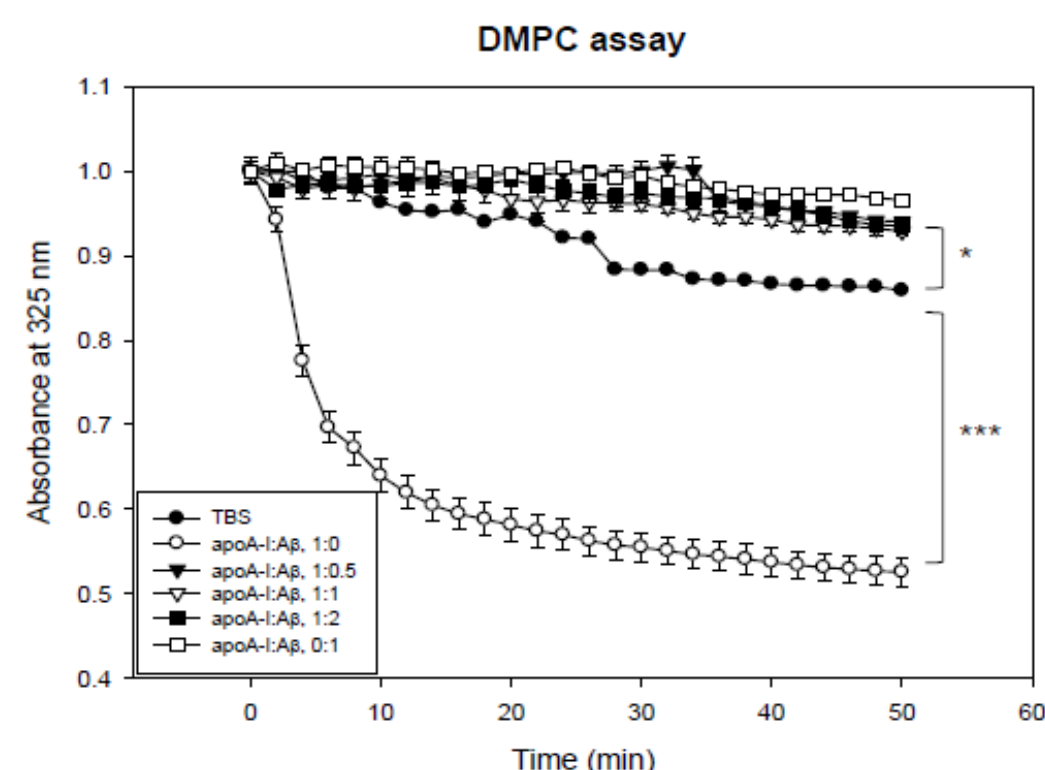
Figure 3. Kinetics of apoA-I and beta-amyloid (A β ) with DMPC multilamellar liposomes. The absorbance at 325 nm was monitored at 24.5 ◦ C at 2 min intervals. *, p < 0.05 between TBS (closed circle) and apoA-I:A β , 1:2; ***, p < 0.001 between TBS and apoA-I:A β , 1:0 (open circle).